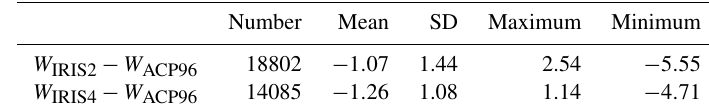
Table 3. The mean differences and the statistics of ( W IRIS2 − W ACP96 ) and ( W IRIS4 − W ACP96 ) (Wm − 2 ) for data from January to Novem- ber 2020, using C = 10 . 5, γ = 6 . 5, τ = 0 . 977 and ε c = 0 . 0225.